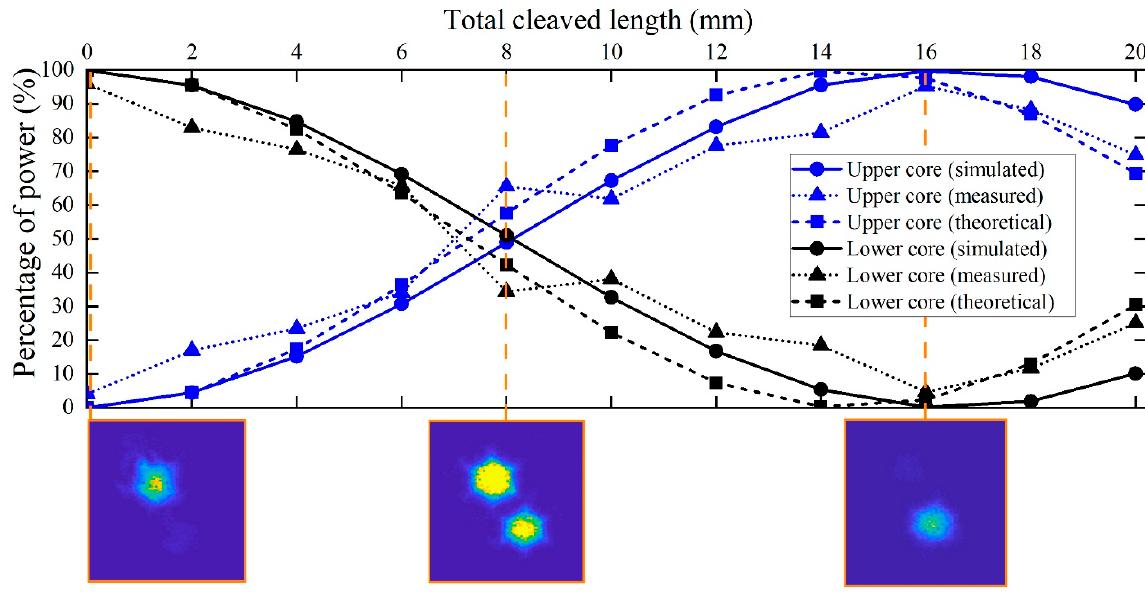
Figure 8. Percentage of power as a function of the total fiber length cleaved from the output end-face of the fiber.